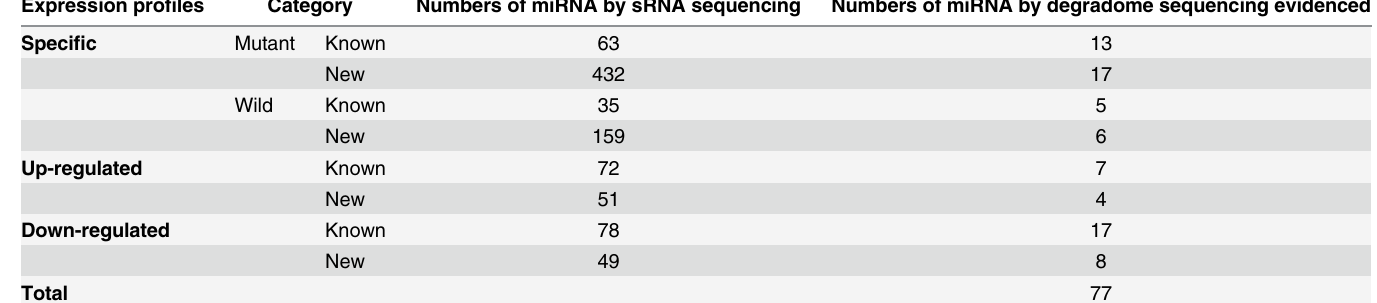
Table 8. Statistics of specifically and differentially expressed